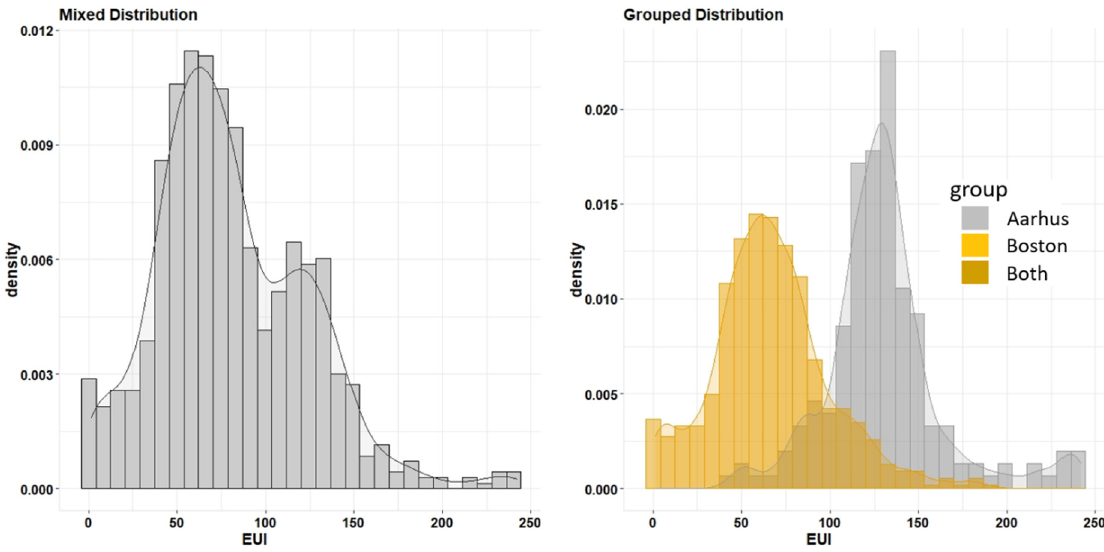
Figure 3. Mixed and grouped distribution of EUI.